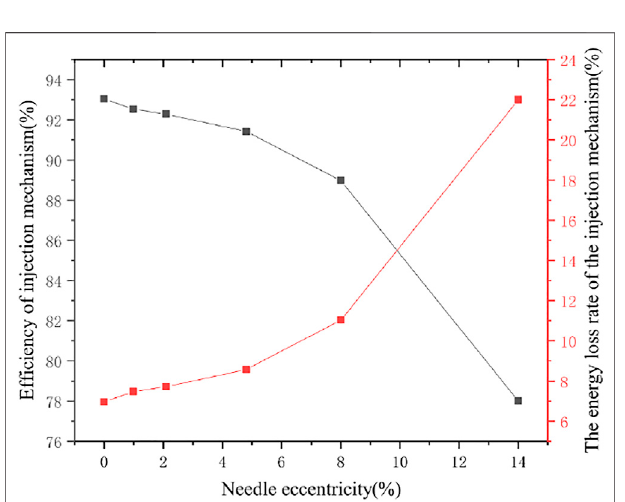
FIGURE 10 | The ef fi ciency and energy loss rate of the injection mechanism under different eccentricities.